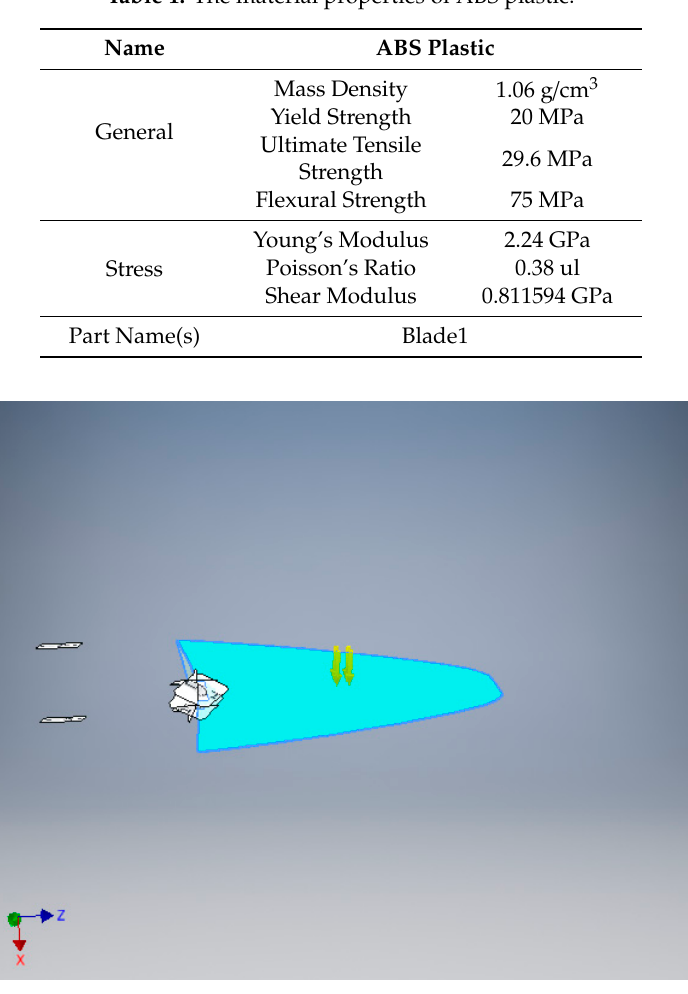
Figure 2. The boundary condition applied to the blade.